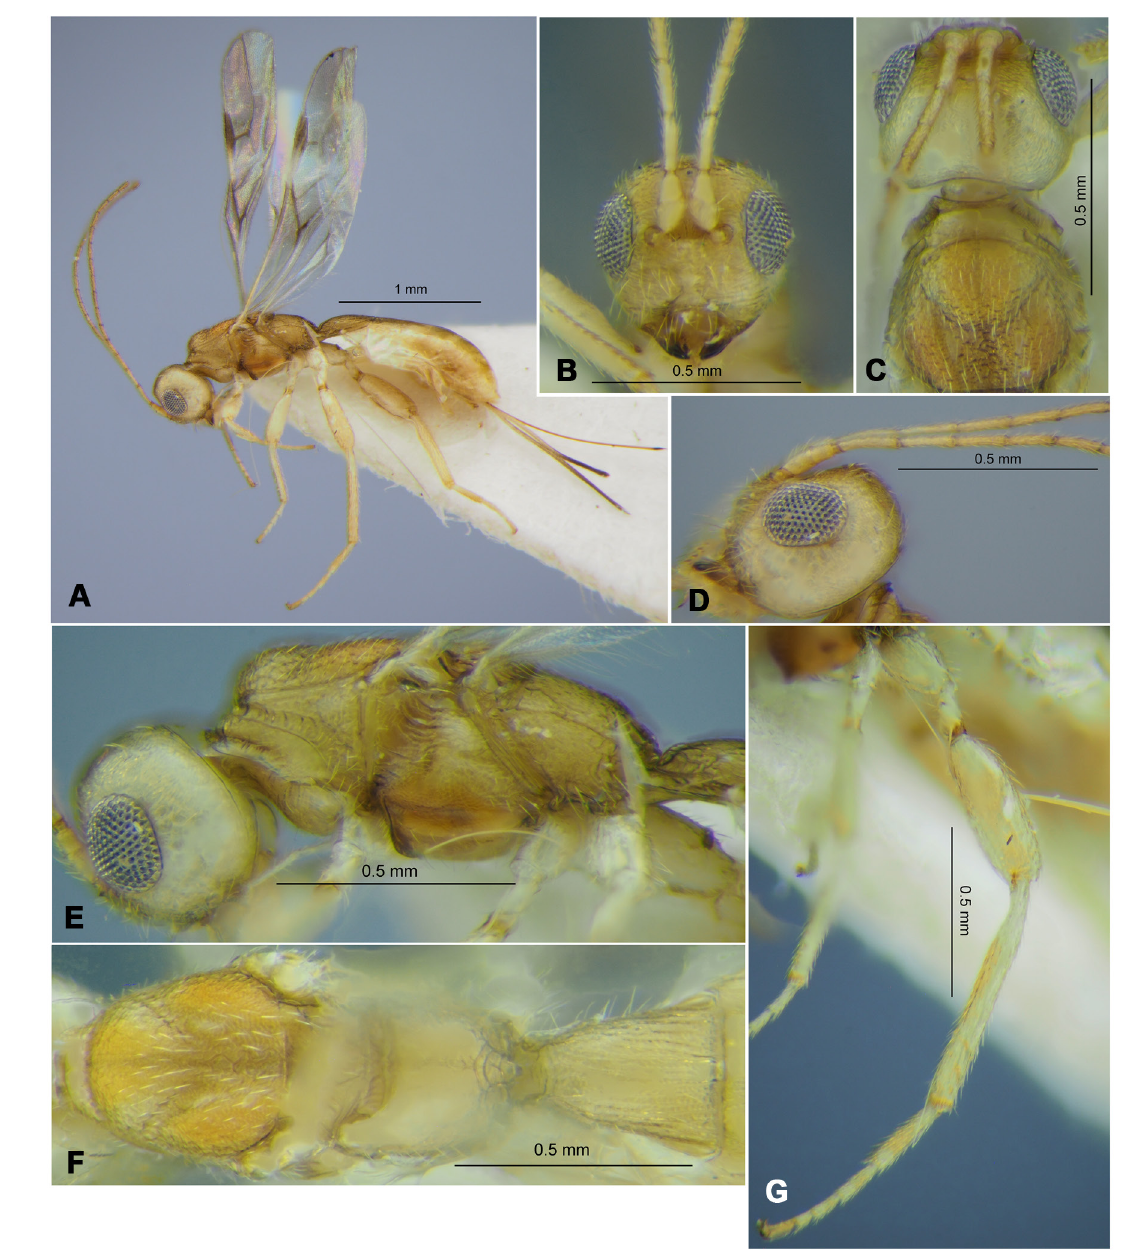
Fig. 5. Dendrosotinus ( Gildoria ) subelongatus Belokobylskij sp. nov., holotype, ♀ (RMNH). A . Habitus, lateral view. B . Head and basal segments of antenna, front view. C . Head and mesoscutum, dorsal view. D . Head and basal segments of antenna, lateral view. E . Head and mesosoma, lateral view. F . Mesosoma and first metasomal tergite, lateral view. G . Hind